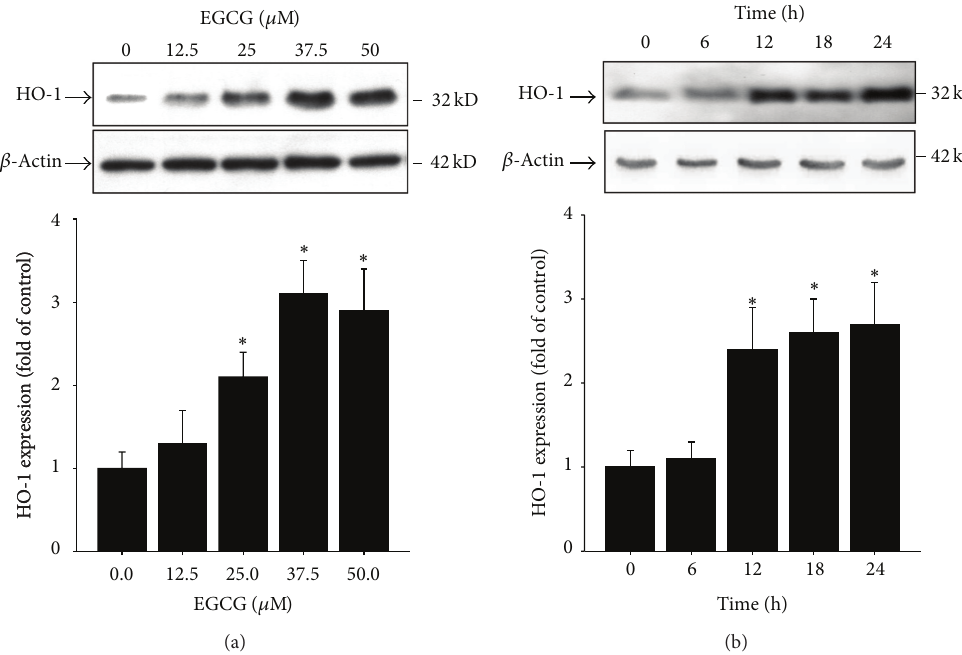
Figure 2: EGCG (a) dose- and (b) time-dependently induces HO-1 protein expression in HASMCs. Data are expressed as mean ± SD of three independent experiments. ∗ 𝑃 < 0.05 compared with medium alone condition.